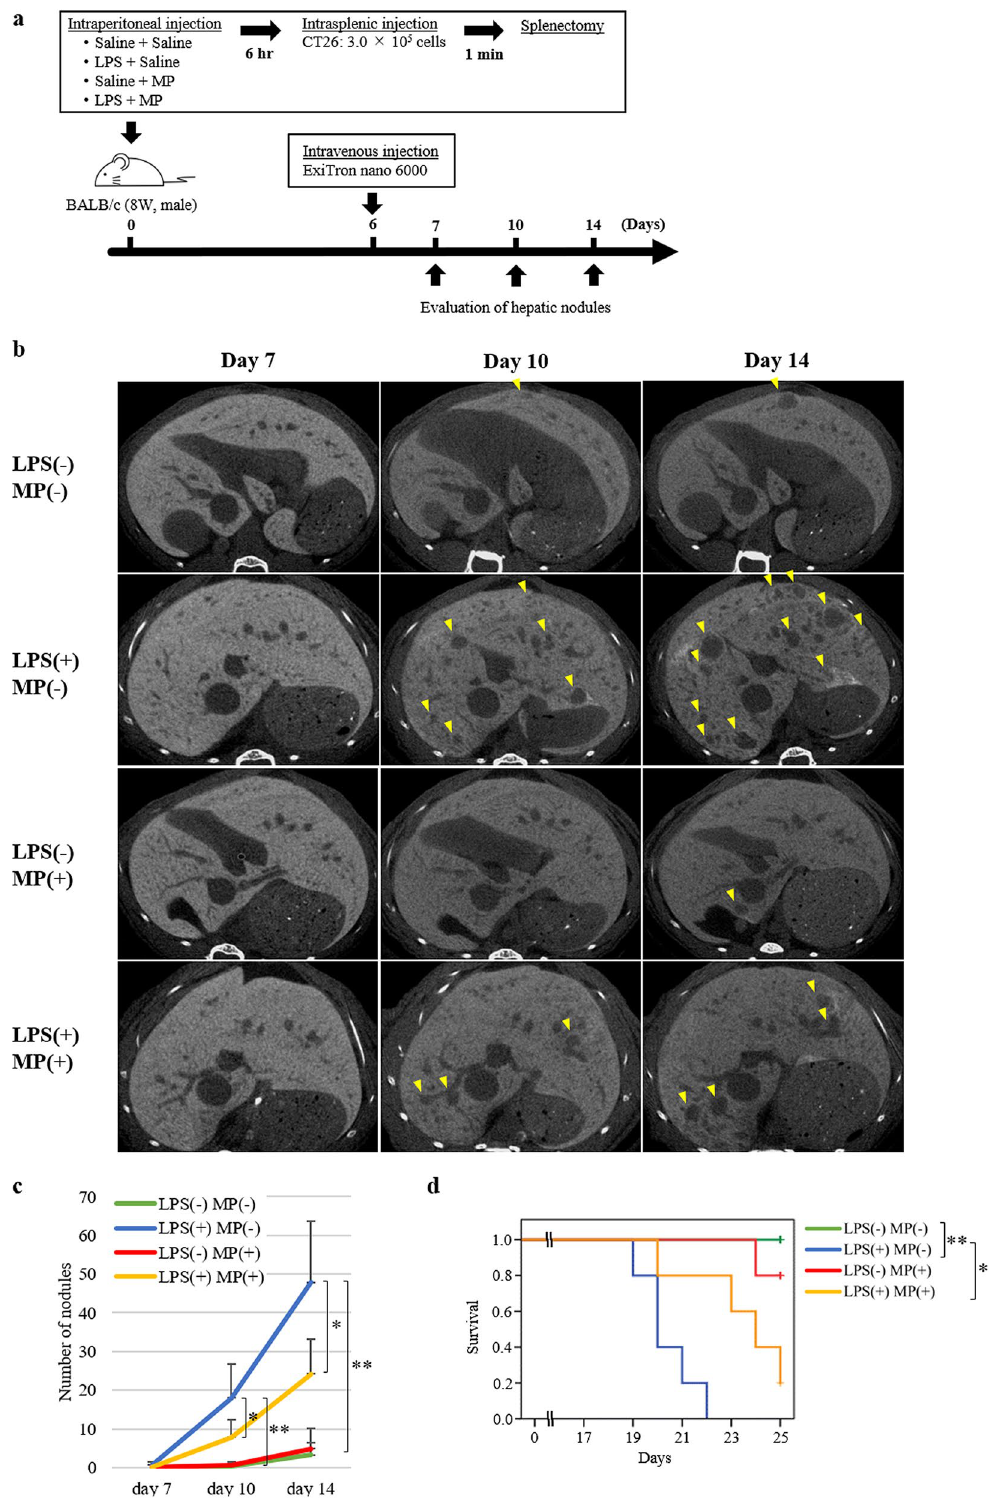
Figure 3. Suppressive effects of MP in LPS-induced murine models of hepatic metastasis. ( a ) Mouse colon cancer cell line (CT26) hepatic metastasis model; male BALB/c mice (8 weeks old) were treated with saline/saline (control), LPS/saline, saline/MP, or LPS/MP. Six hours later, 3.0 × 10 5 CT26 cells were injected into the inferior pole of the spleen, followed by splenectomy 1 min later. The number of hepatic nodules was evaluated using enhanced micro-CT imaging on days 7, 10, and 14. ( b ) Representative CT images of the liver. Almost the same liver slice from the same individual in each group was photographed axially on days 7, 10, and 14. Yellow arrowheads indicate nodules with a diameter of more than 50 µm. ( c ) Metastatic nodules in the liver were quantified on days 7, 10, and 14. Data are means ± standard error (n = 5, each group); * P < 0.05, ** P < 0.001. ( d ) Kaplan–Meier survival curves of each group of hepatic metastasis model mice. The horizontal axis represents the days from inoculation of tumour cells and the vertical axis represents the survival rate. Tick marks represent censored subjects. *Log-rank P < 0.05, **log-rank P <